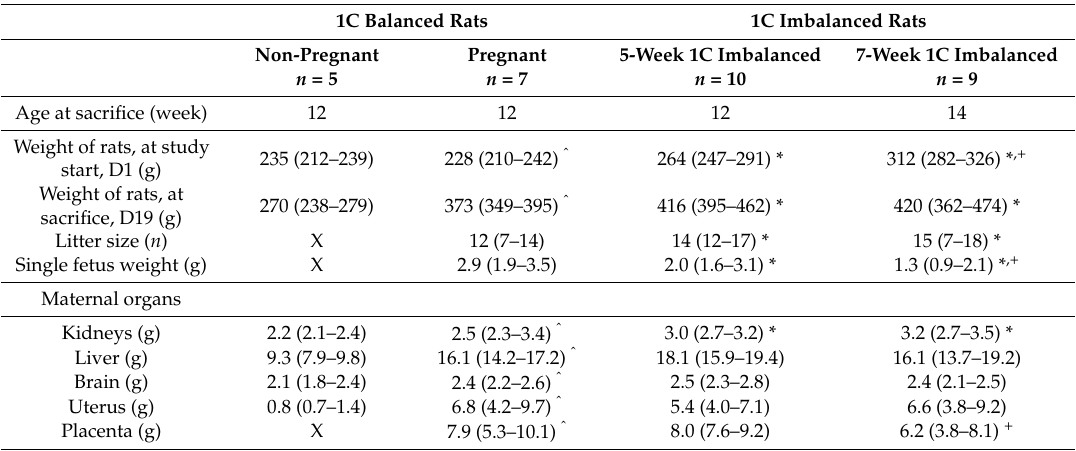
Table 2. Basic characteristics. 1C balanced and imbalanced rats and their offspring at pregnancy day 19 out of 21.